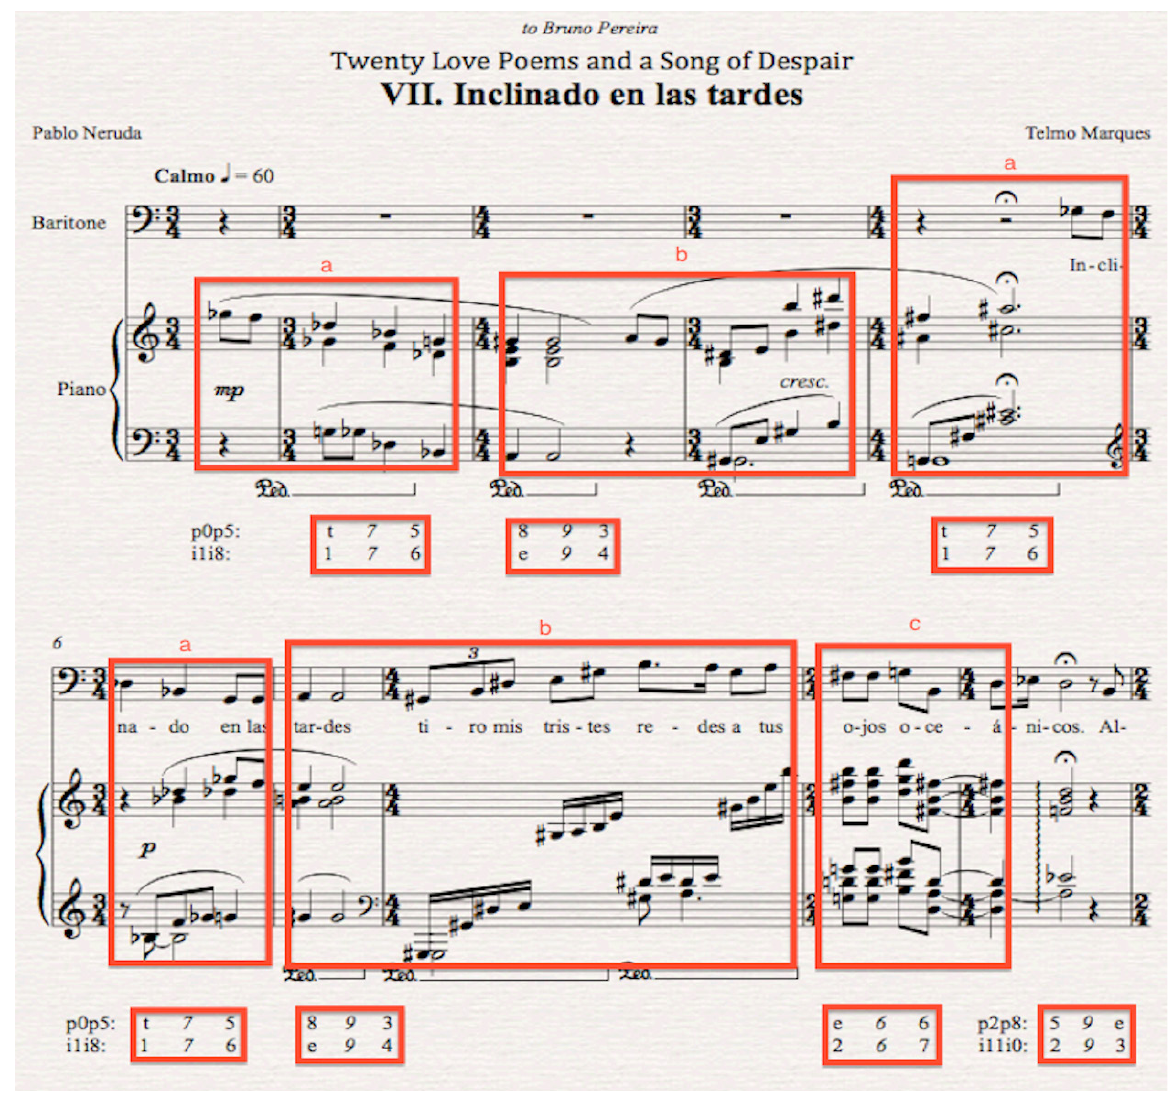
FIGURE 6 | Practical